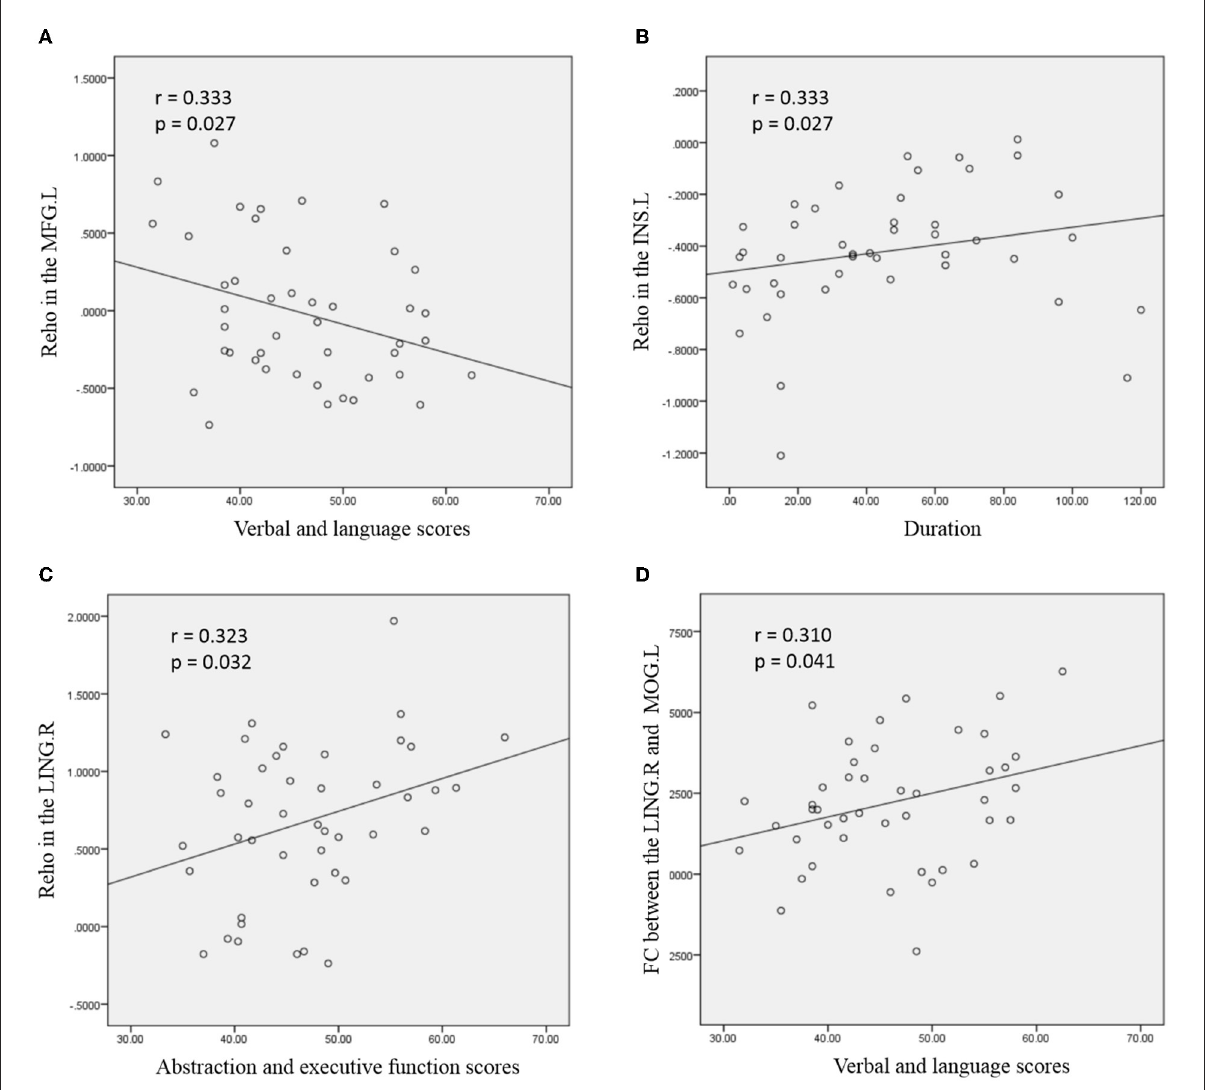
FIGURE3 Correlation between abnormal regional homogeneity (ReHo)/functional connectivity (FC) and clinical variables in young HIV-infected patients with ANI. (A) depicts the mean ReHo in the left middle frontal gyrus (MFG. L), which was negatively correlated with the verbal and language scores; (B) shows the mean ReHo in the left insula (INS. L), which was positively correlated with the disease duration; (C) depicts positive correlations between mean ReHo in the right lingual gyrus (LING. R) and abstraction and executive function scores; (D) depicts the increased FC between the LING. R and left middle occipital gyrus (MOG. L), which was positively correlated with verbal and language performance. The threshold was set at p < 0.05 without multiple comparison